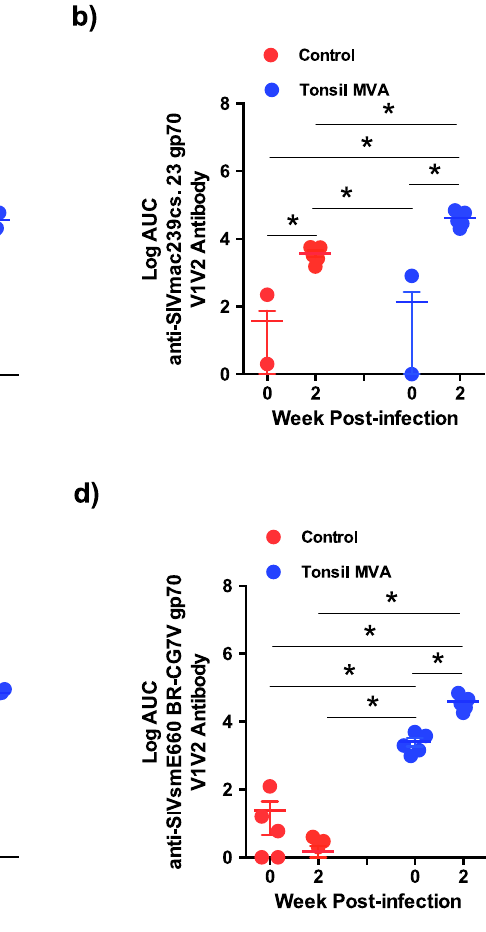
Fig.4|Tonsilvaccinationinducedsigni fi cantlevelsofV1V2speci fi cantibodies againsthomologousandheterologousstrainsofSIV. ( a )SIVmac251-WY30gp70 V1V2 antibody (week 0 control vs week 2 control P =ns; week 0 control vs week